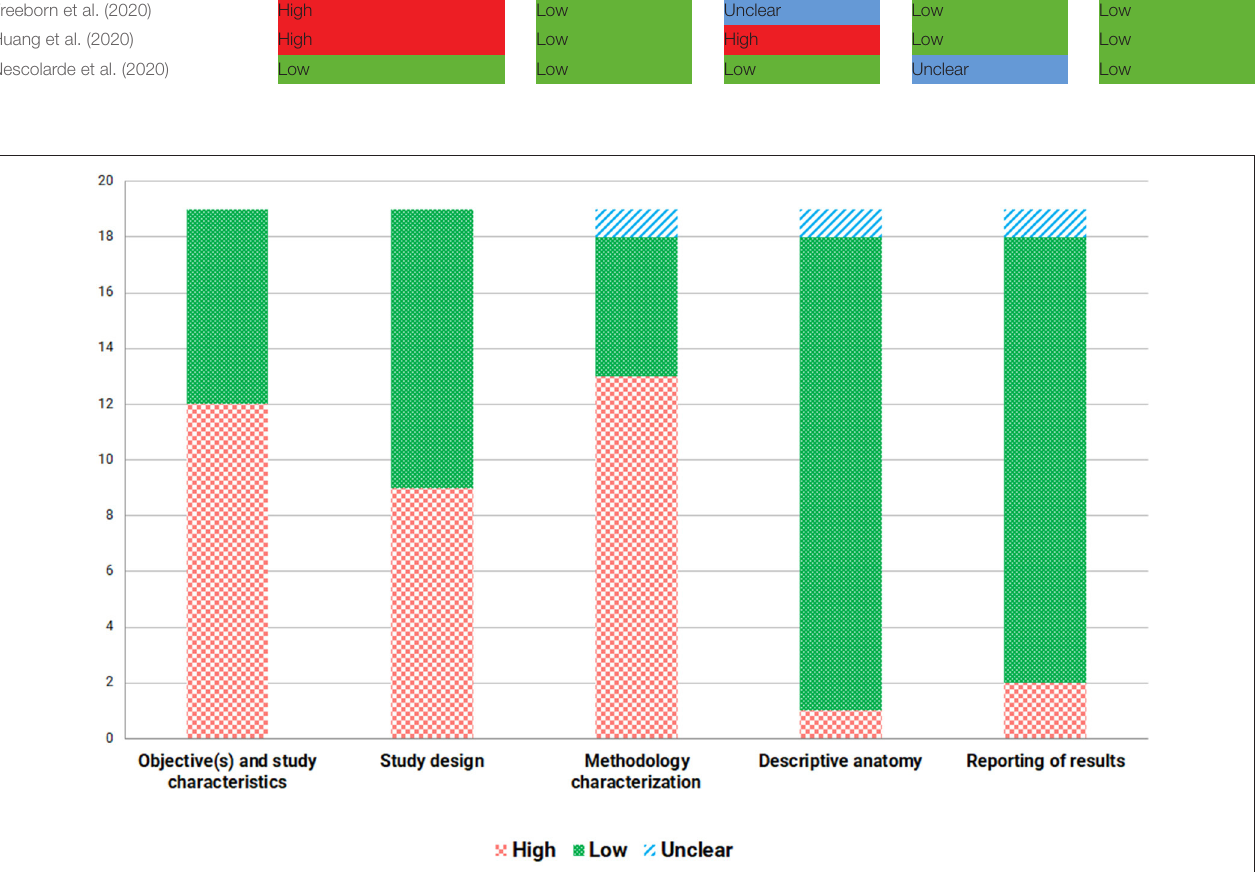
FIGURE 2 | Diagram of the quality assessment of the studies